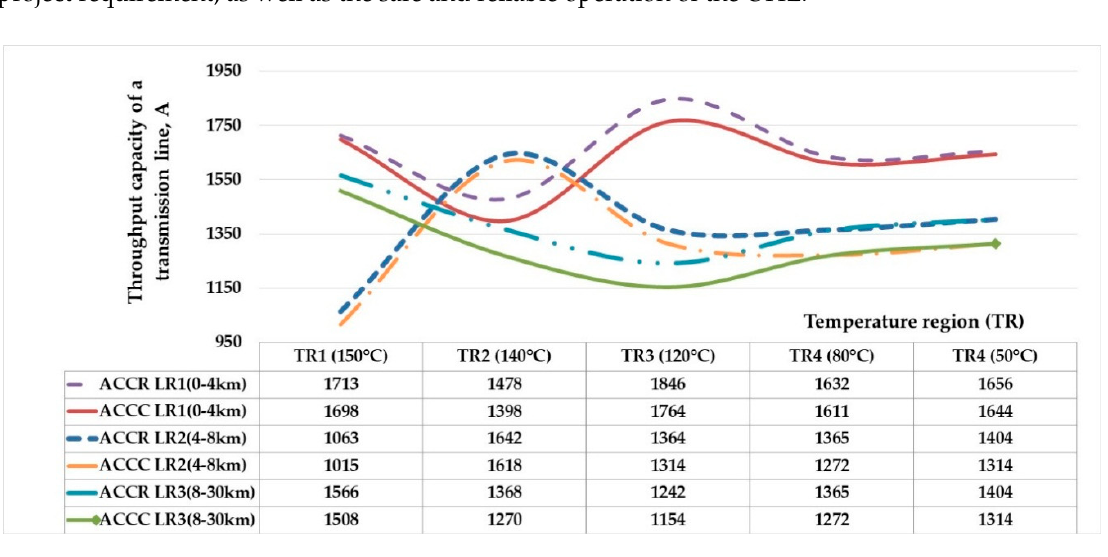
Figure 11. Capacity comparison of ACCC and ACCR types based on selected final cross-sectional areas of conductor for “OHL No.1”.